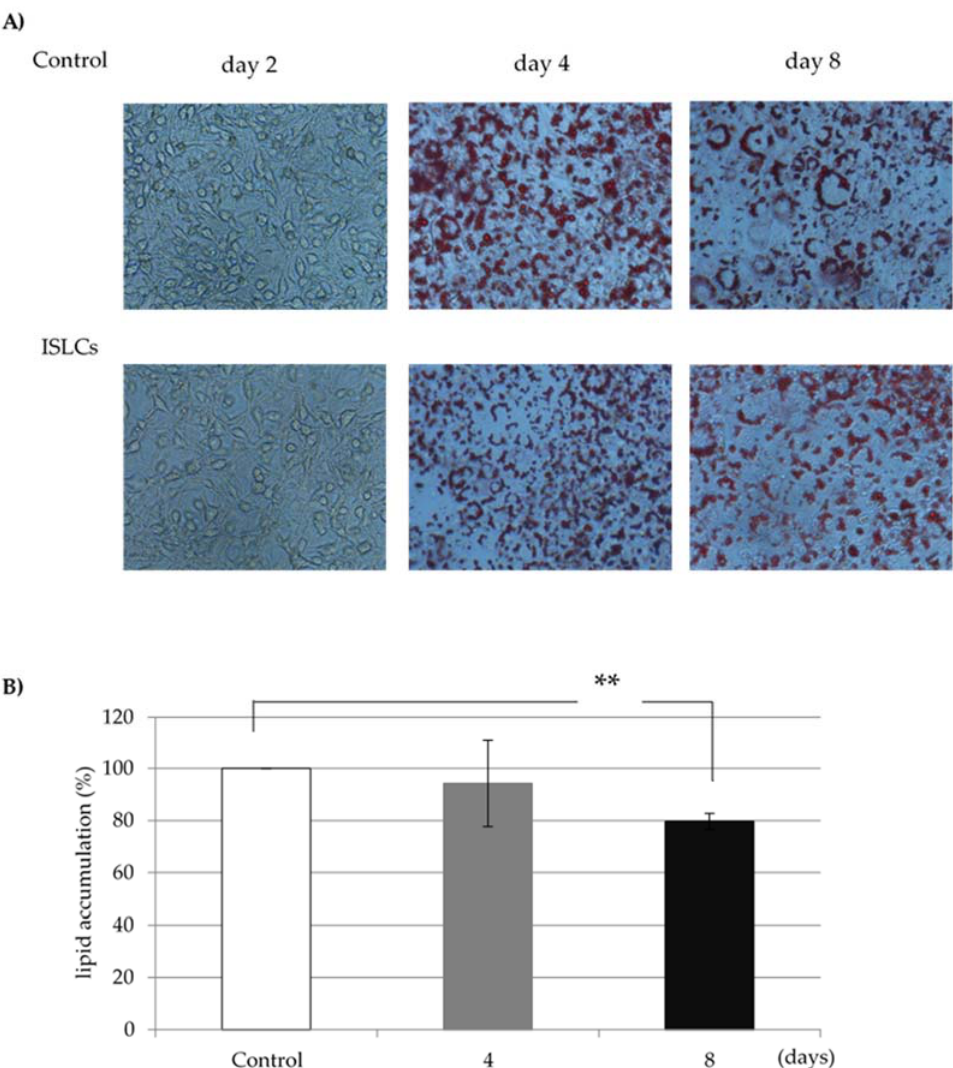
Figure 1. Effect of ISLCs on lipid accumulation in 3T3-L1 cells. ( A ) Lipid droplets of control cells and ISLC-treated cells after Oil Red O staining. ( B ) Comparison of lipid accumulation in 3T3-L1 cells. The cells were cultured in medium including 1.0 mg/mL ISLCs for 4 and 8 days after differentiation. The cells in the medium without ISLCs were used as a control. The ratio of lipid accumulation was expressed relative to untreated control cells (100%). Values are expressed as the mean ± SD; ** p < 0.01, compared to control cells.